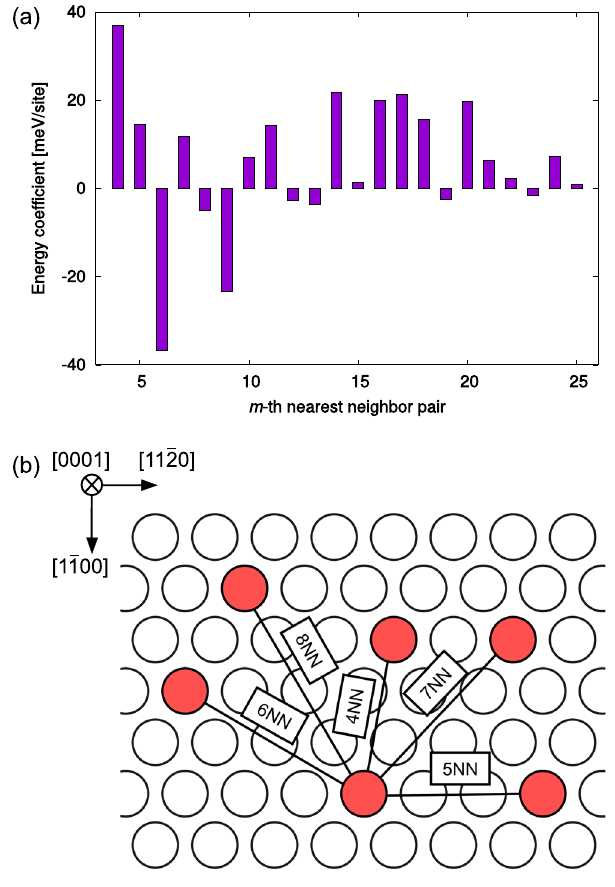
Figure 2. ( a ) Energy coefficients estimated by geometrical information, i.e., the SROs of Zn–Y clusters evaluated from a single STM image on the right-hand side of Fig. 1. ( b ) Schematic illustration of m NN pairs ( m = 4–8) at the interface.